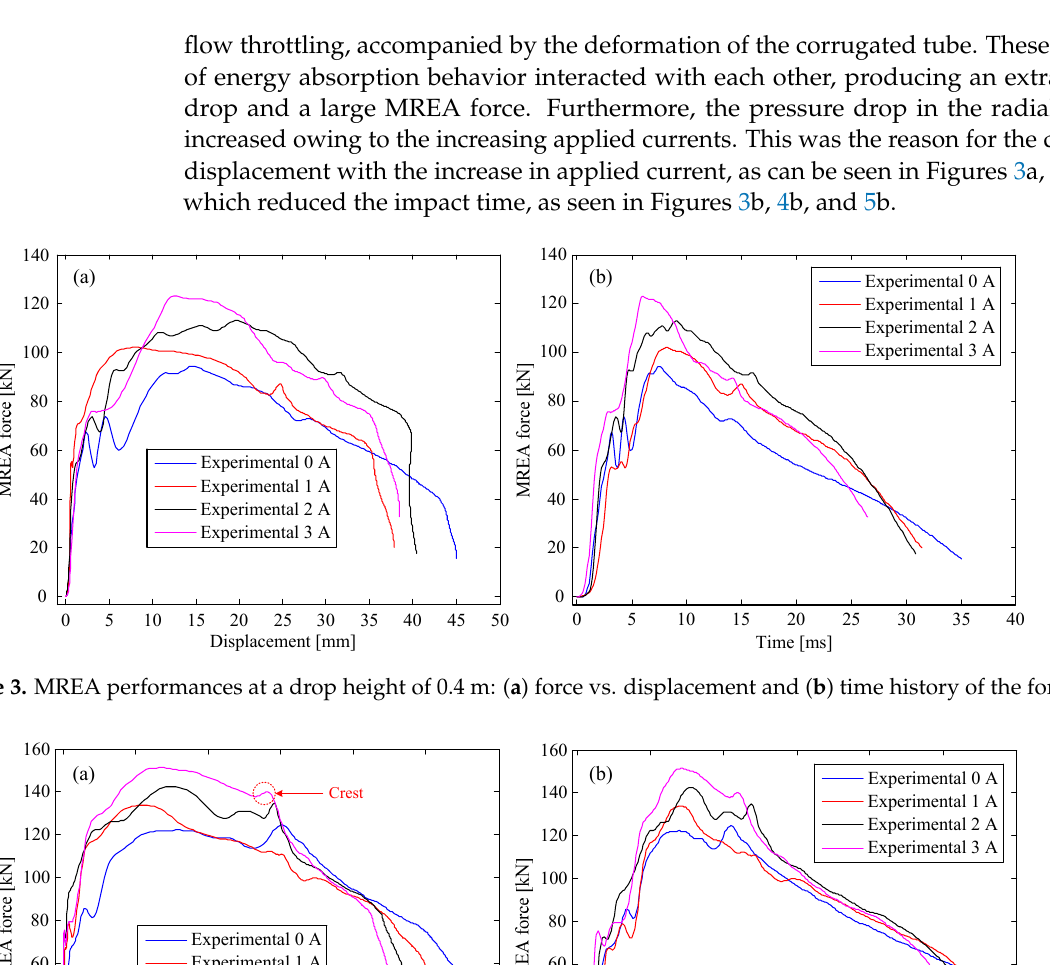
Molecules 2021 , 26 , x FOR PEER REVIEW